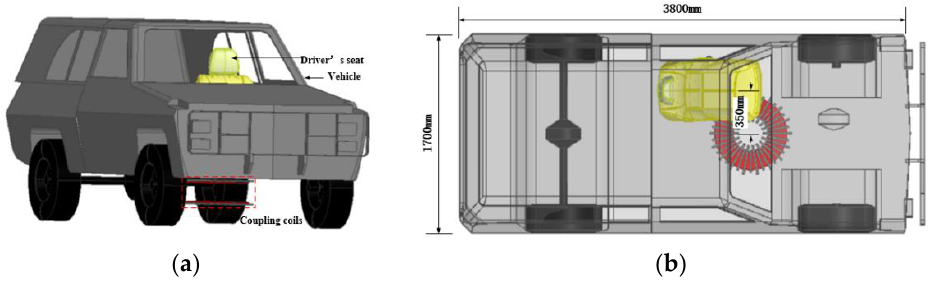
Figure 10. 3D model of the vehicle body: ( a ) Side view; ( b ) Top view.